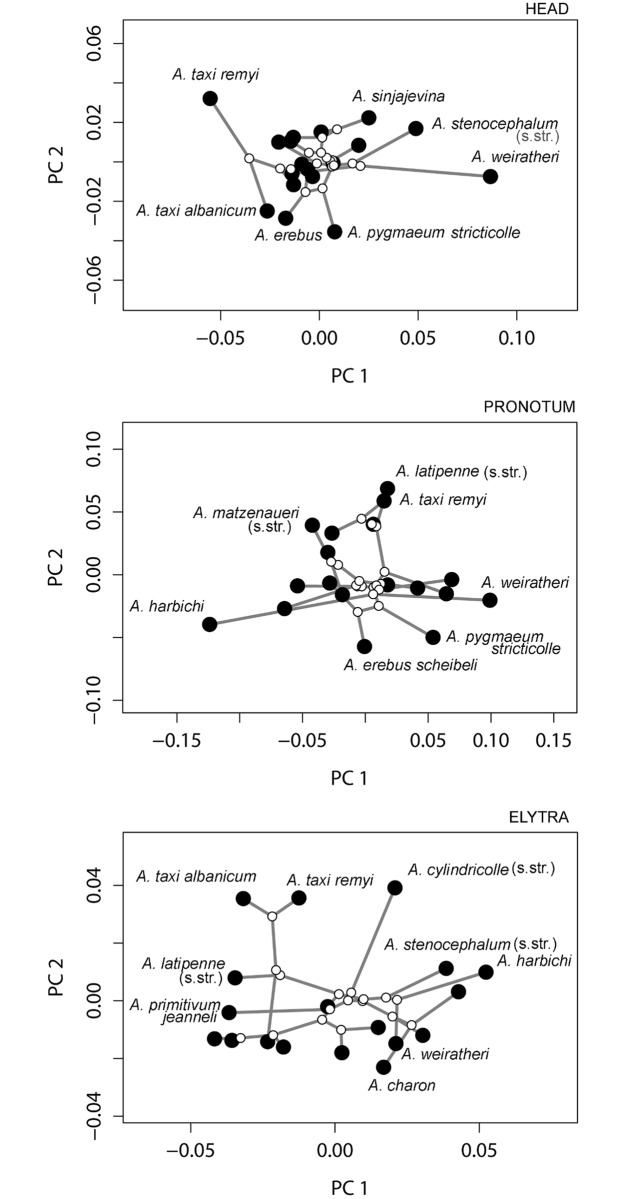
Phylomorphospaces for the genus Anthroherpon, shown for each body part separately.Open symbols are internal nodes; filled symbols are terminal nodes. Only the two first principal components of a principal component analysis of each shape are depicted.